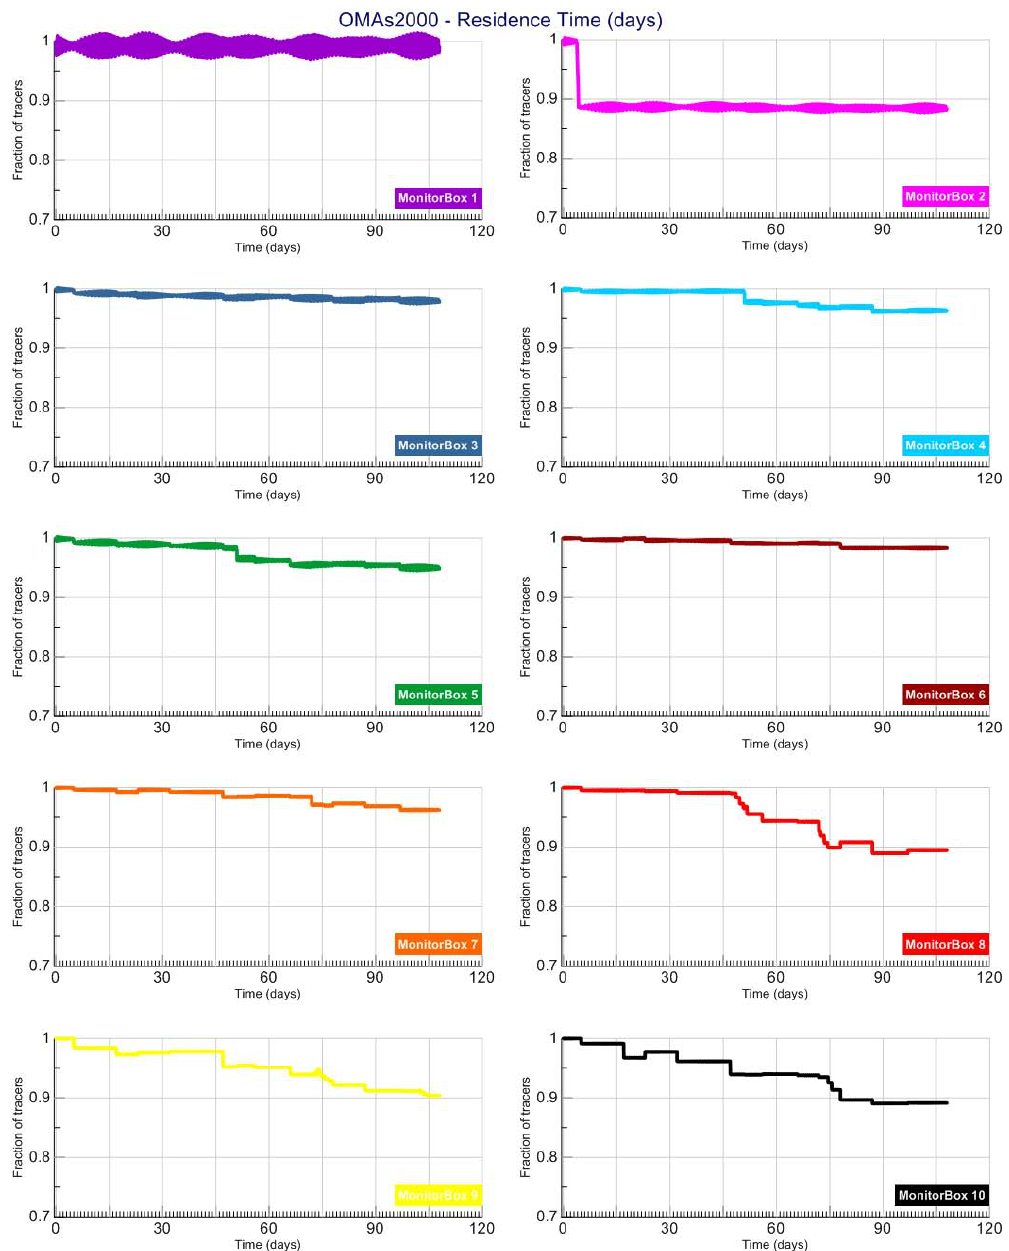
Fig. 4. The residence time of the 2000µm OMAs in each monitor box over the simulated period. The monitor boxes are set at increasing depths from box 1 to box 10: 59m, 262m, 357m, 575m, 331m, 945m, 1498m, 2077m, 2657m, and 3189m.